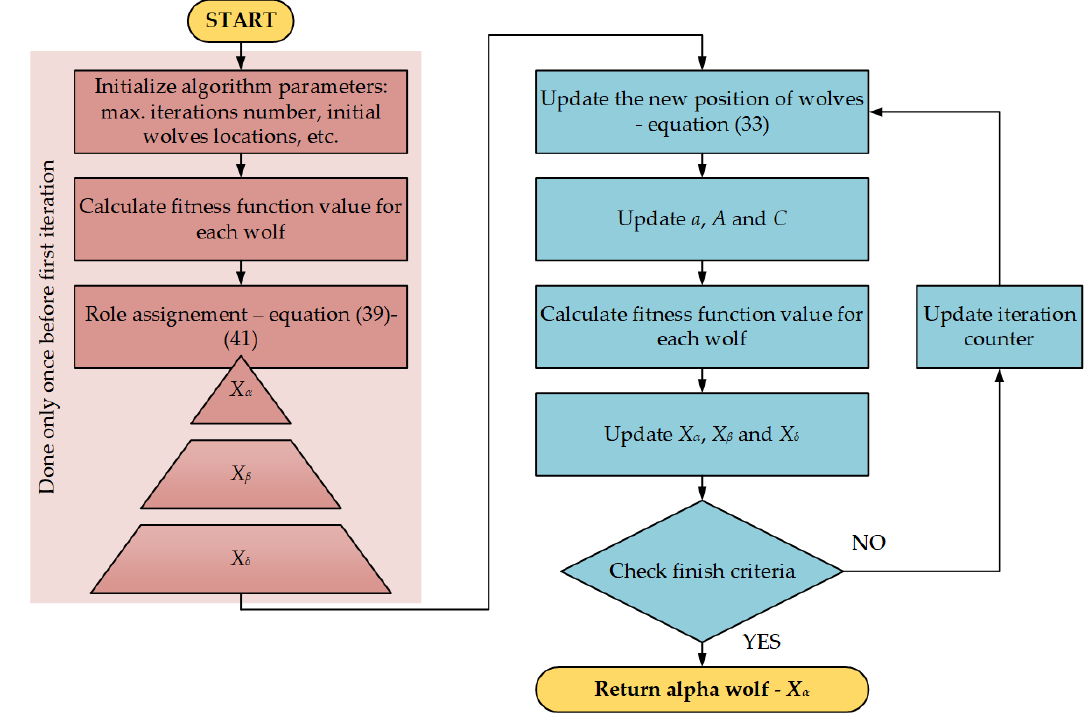
Figure 4. The Grey Wolf Optimizer.